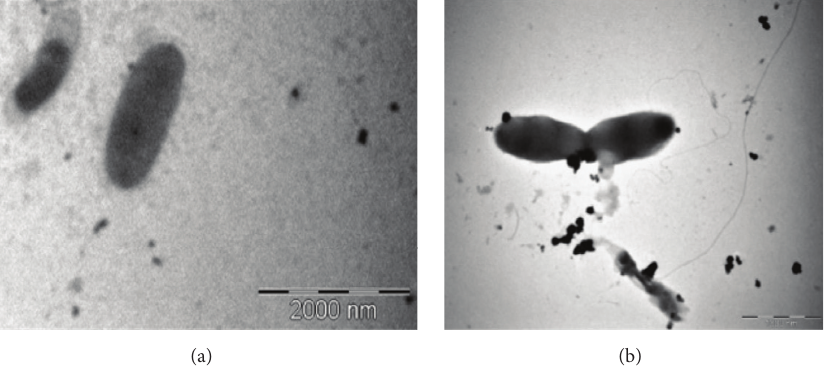
Figure 1: TEM image of Burkholderia sp. VITRSB1 with single flagellum at the end of the bacteria. Samples were stained with osmium tetroxide. Magnification: 17500x; (a) the rod shape of the Burkholderia is evident from the TEM image; (b) the flagellum is clearly visible at the end of the bacteria.